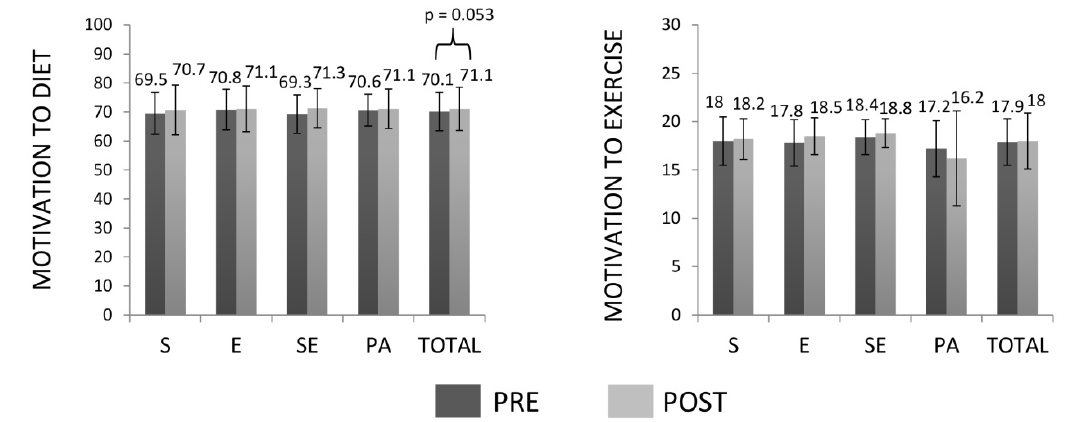
Figure 4. Motivation to diet and exercise before and after the intervention. S: strength training group; E: endurance training group; SE: strength and endurance training group; PA: physical activity recommendations group.